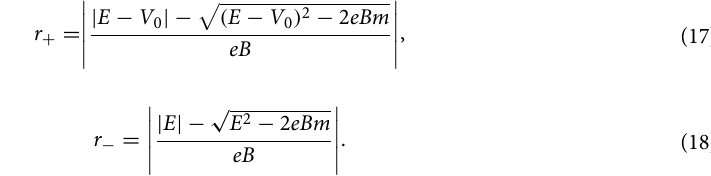
1 / 2, 3 / 2, and 5 / 2 , respectively, on B for m = ± ± ± −